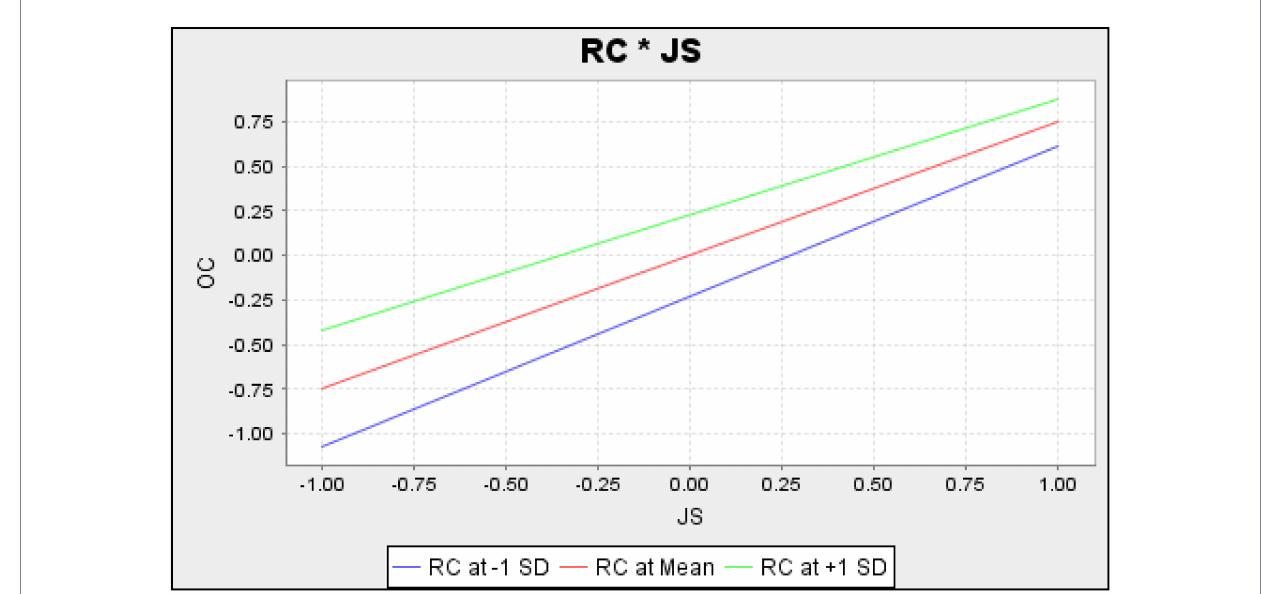
FIGURE 5 Moderation effect of role conflict between job satisfaction and organizational commitment.